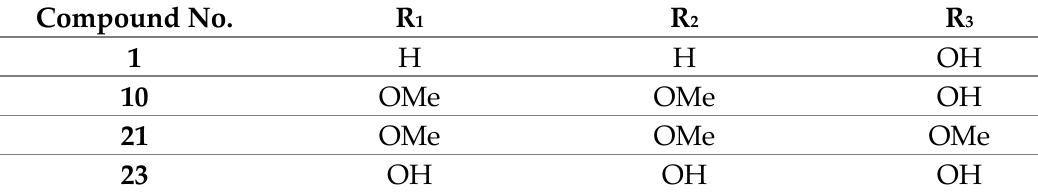
Figure 9. Fragmentation pathway of compounds 1 , 10 and 23 .